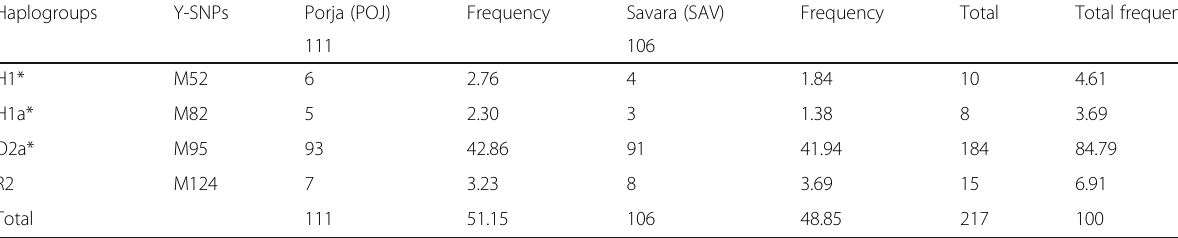
Table 1 Y haplogroup distribution of the studied populations (Porja and Savara) Haplogroups Y-SNPs Porja (POJ) Frequency Savara